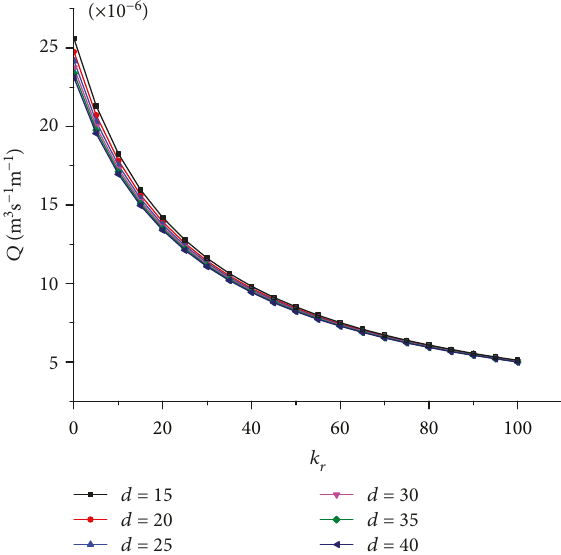
Figure 10: Relationship between the pressure head and tunnel radius.